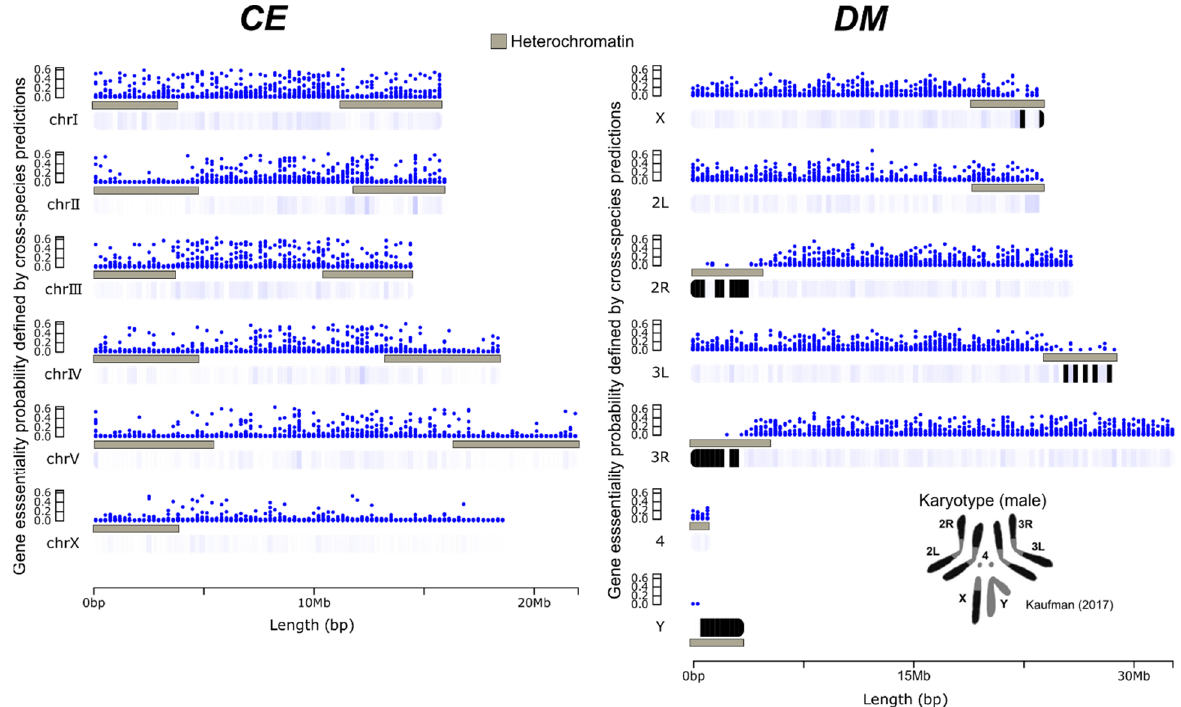
Figure 4. Distribution landscape of essentiality probabilities along CE and DM chromosomes. Essentiality probabilities defined by the XGB models ( x -axis) for the cross-species predictions were plotted for each gene coordinate ( y -axis). Heterochromatin regions defined by previous studies for CE [27] and DM [28] are depicted in grey. Heatmaps below each chromosome show the areas with higher (dark blue) and lower gene densities (white), and no data (black). Additional information on karyotype for DM [28] shows the relationship between chromosome segments.